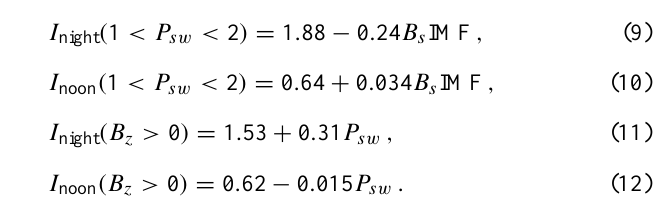
Fig. 4. . Total current flowing at radial distances from 4 to 9 R E vs. (left) B z IMF in a narrow range of P sw , and (right) P sw under positive B z IMF in four LT Figure 4. Total current flowing at radial distances from 4 to 9 R versus (left) B IMF in a narrow E z range of P , and (right) P under positive B IMF in four LT sectors. sw sw z